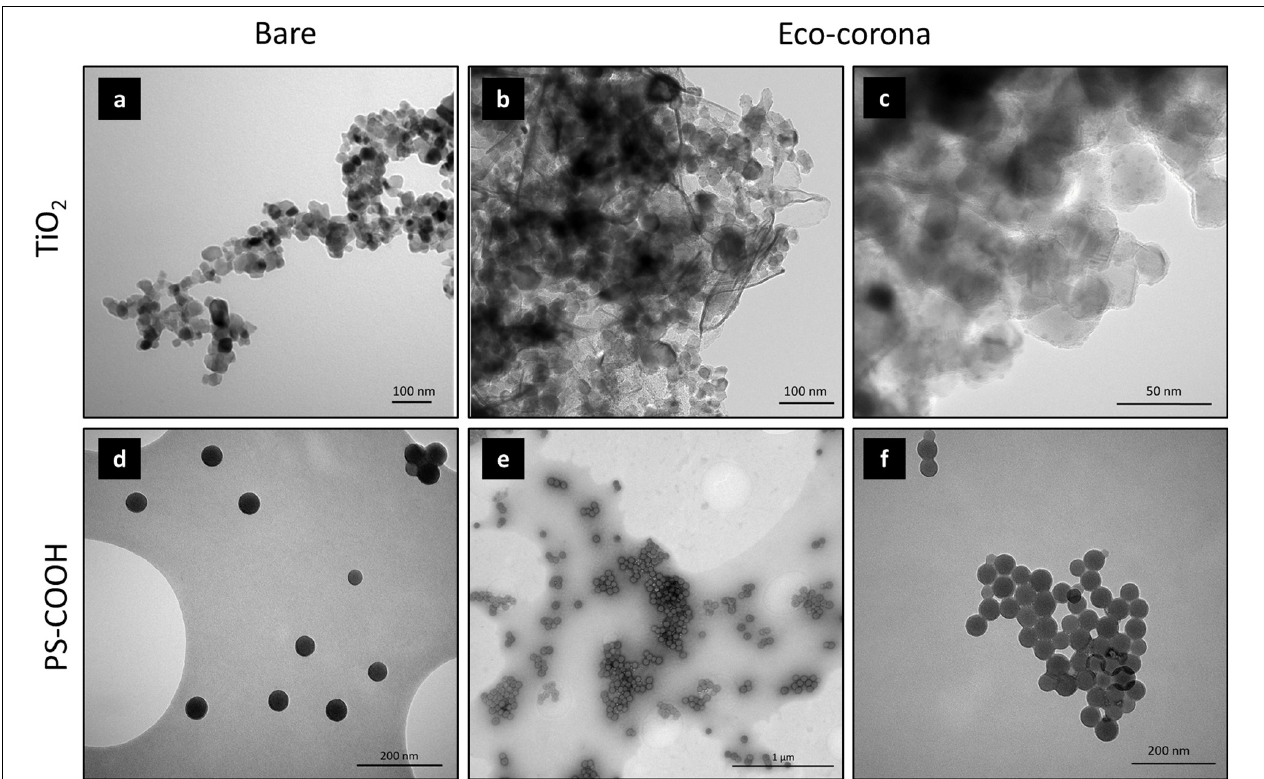
FIGURE 2 | Transmission electron microscopy (TEM) showing interactions of 25-nm titanium dioxide (TiO 2 ) P25 (a,b,c) and 60-nm carboxylate (PS-COOH) (d,e,f) NPs with marine NOM leading to eco-corona formation. Bare particles in deionized water are reported in panels (a,d) . (b,c) TiO 2 NP interactions with biomolecules form natural seawater. (e,f) PS-COOH NP interaction with EPS from the marine diatom Phaeodactylum tricornutum . Details of sample preparation are reported in the Supplementary Material section.